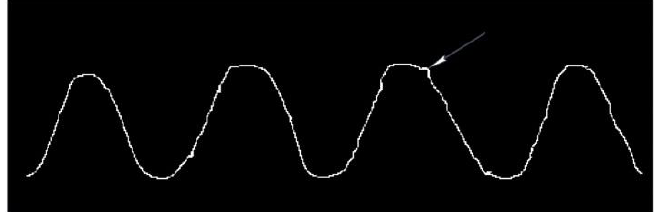
Figure 7. The result of processing the initial image with morphological operators infill and skel : the arrow points to the dislocation of artifacts (pixels, where the operators work incorrectly, are